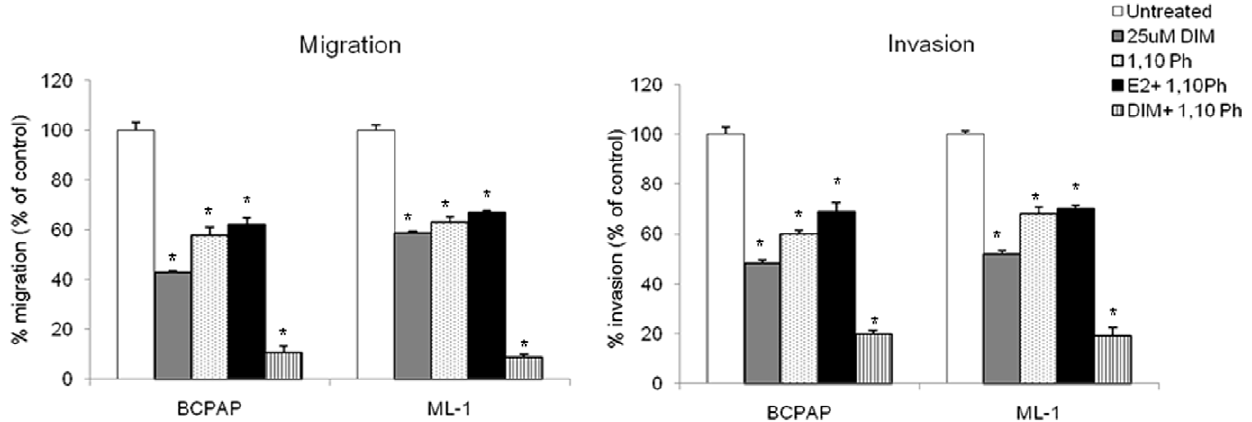
Figure 6. MMP inhibitor 1,10 phenanthroline attenuates migration and invasion of thyroid cells. Thyroid cells were treated with 10 2 8 M E 2 6 MMP inhibitor (1,10 Ph) 6 25 m M DIM or left untreated and percent migration and invasion of treated cells was determined compared to untreated cells which were set to 100%.